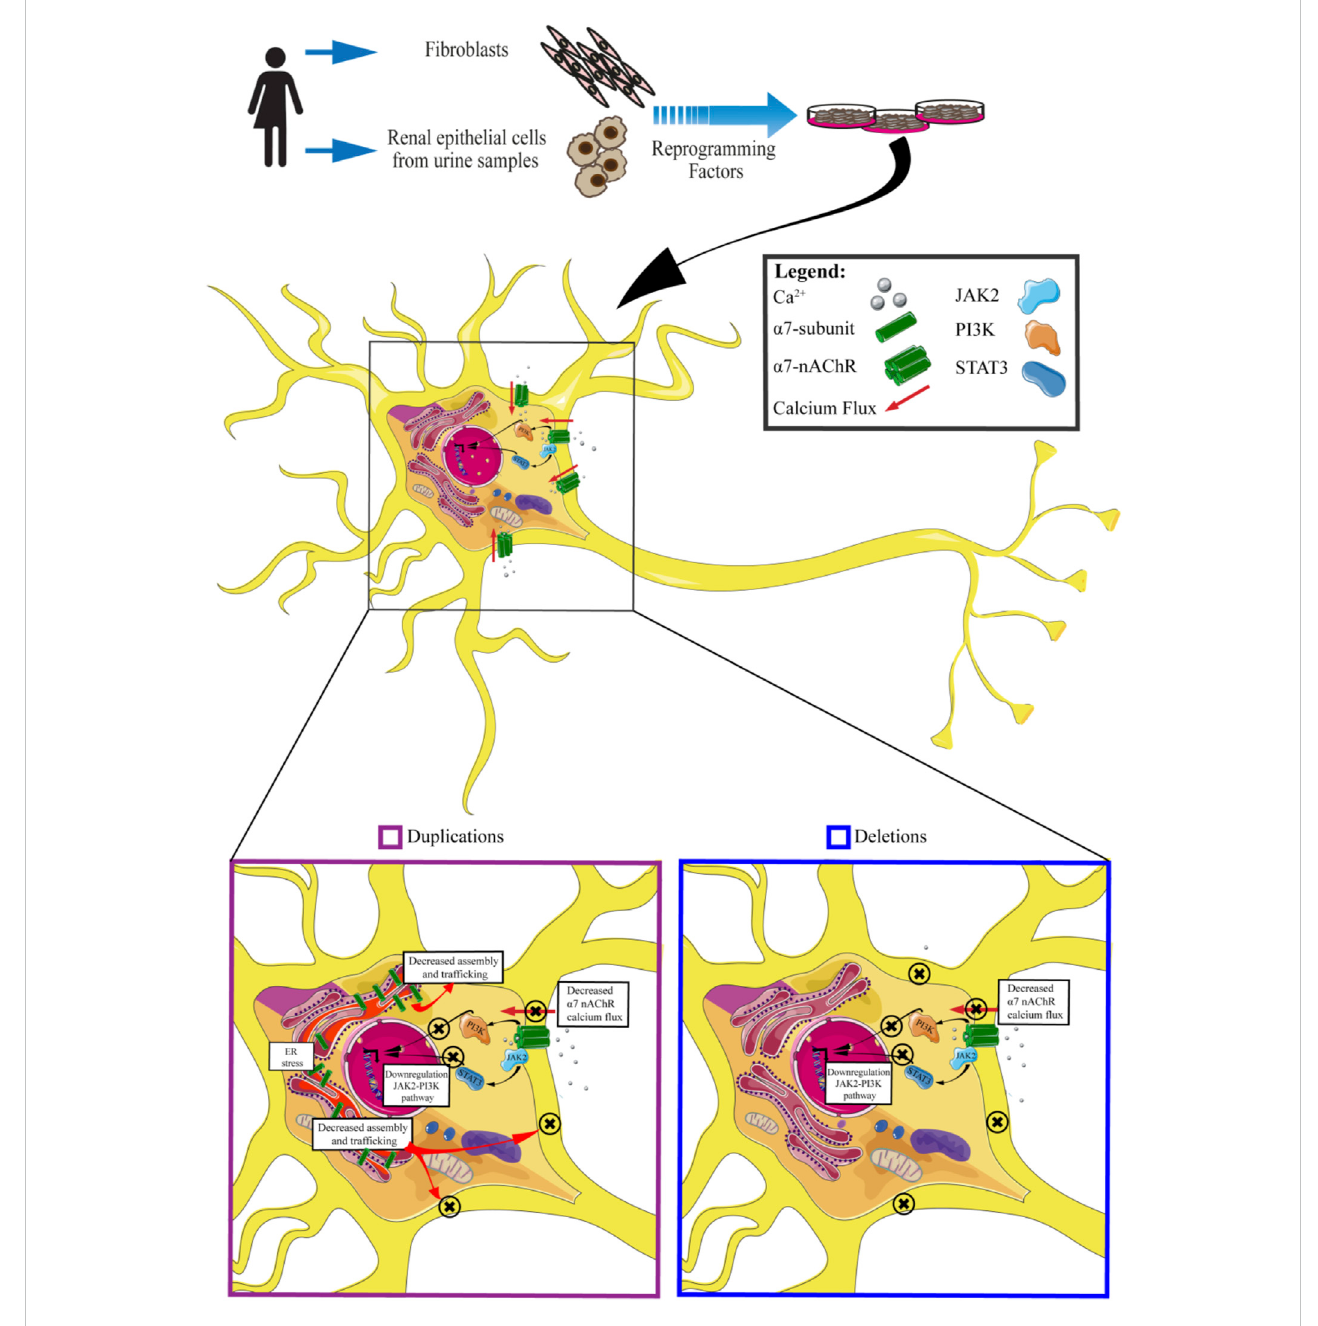
An insight into molecular effects of CNV 15q13.3. Cells carrying CNV duplications show decreased calcium fl ux associated with the α 7 receptor, downregulation of JAK2-PI3K pathway, decreased assembly and traf fi cking of nAchRs, and ER stress. Cells carrying CNV deletions exhibit decreased α 7nAchRs calcium fl ux and downregulation of JAK2-PI3K